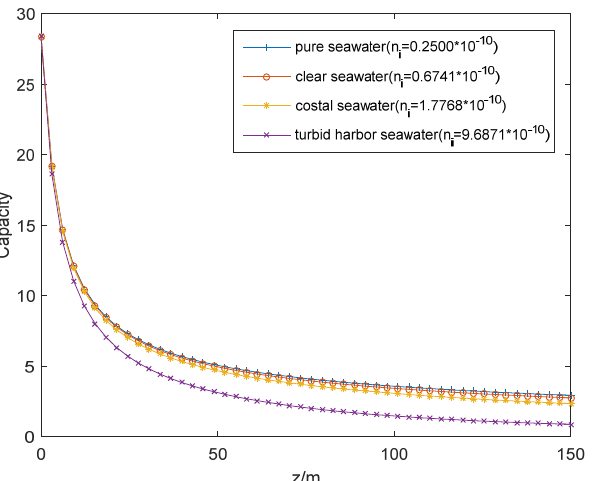
Figure 7. Channel capacity of the link with the random double-position power Gaussian vortex carrier and wavelength λ = 561 nm versus pure seawater, clear seawater, costal seawater, and turbid harbor seawater.